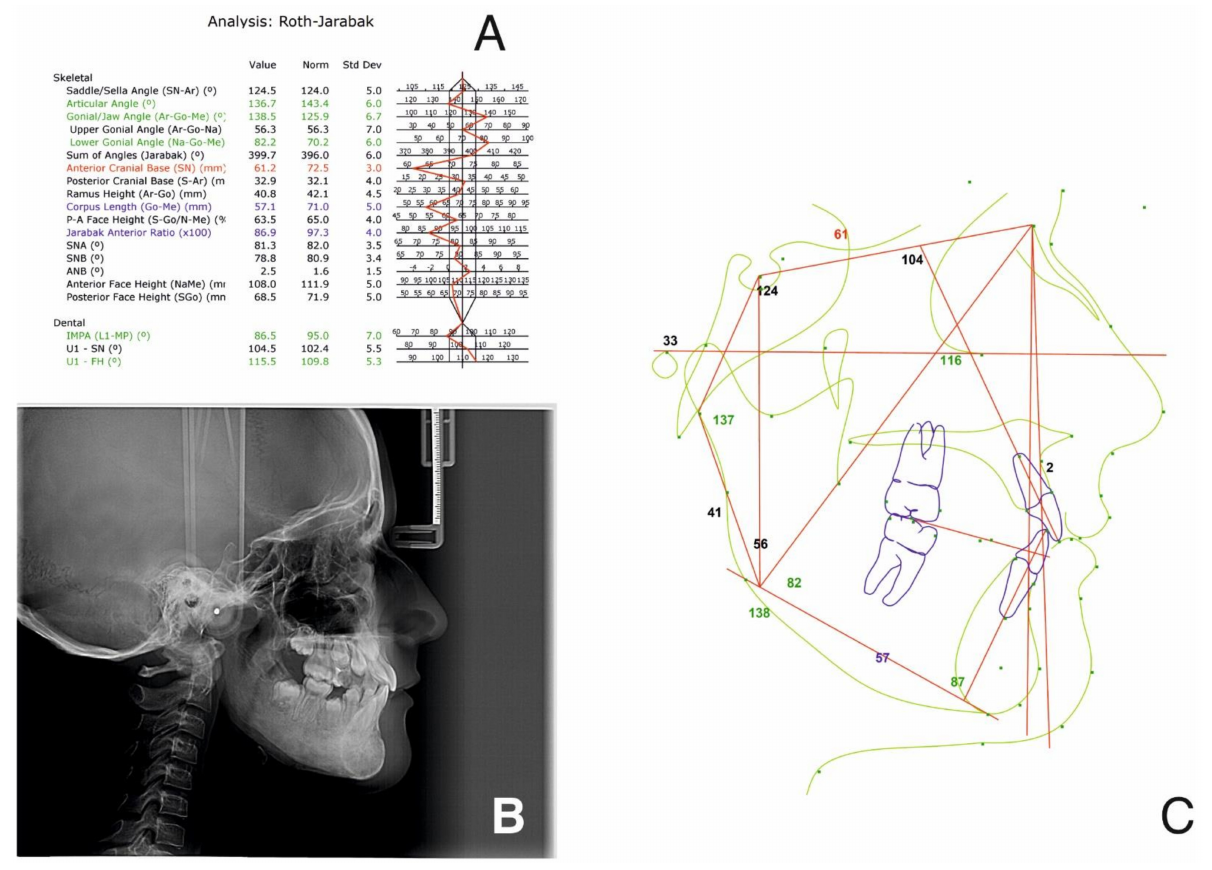
Figure 7. Pre-treatment cephalometric analysis: Roth Jarabak cephalometric analysis ( A ), cephalometric radiograph ( B ), landmarks and reference lines of the cephalometric analysis ( C ).